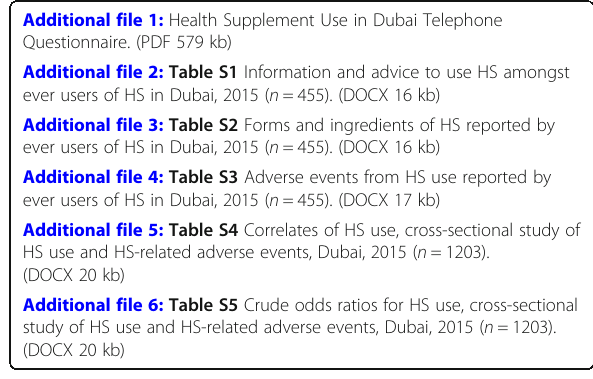
Additional file 4: Table S3 Adverse events from HS use reported by ever users of HS in Dubai, 2015 ( n = 455). (DOCX 17 kb) Additional file 5: Table S4 Correlates of HS use, cross-sectional study of HS use and HS-related adverse events, Dubai, 2015 ( n = 1203). (DOCX 20 kb) Additional file 6: Table S5 Crude odds ratios for HS use, cross-sectional study of HS use and HS-related adverse events, Dubai, 2015 ( n = 1203). (DOCX 20 kb) Abbreviations AE: Adverse Events; AED: Emirati Dirham; AOR: Adjusted Odds Ratio; CI: Confidence Interval; F: Female; HS: Health Supplements; M: